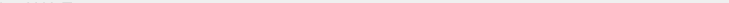
Table 1: Description of intervention programme according to the AHA Taxonomy. Patient